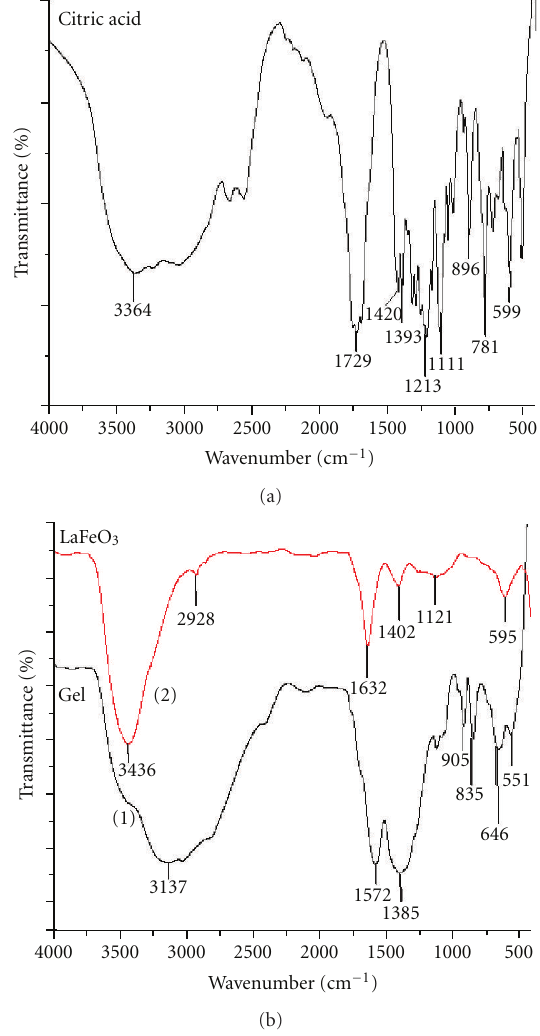
Figure 2: (a) FTIR spectra of citric acid; (b) FTIR spectra of gel complex (black line) and LaFeO 3 (red